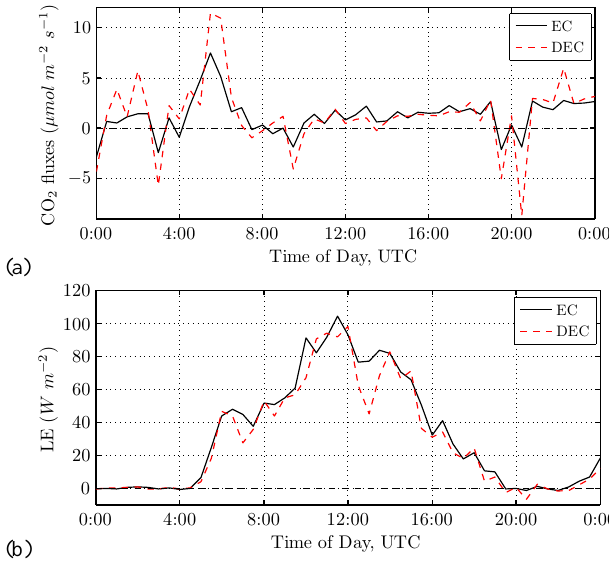
Fig. 9. Same as Fig. 7, but for “real” DEC instead of simulated DEC fluxes.